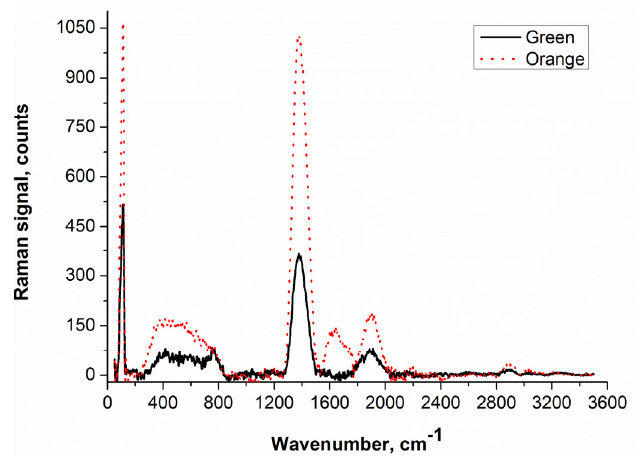
Figure 11. Raman spectra of the green and orange samples.